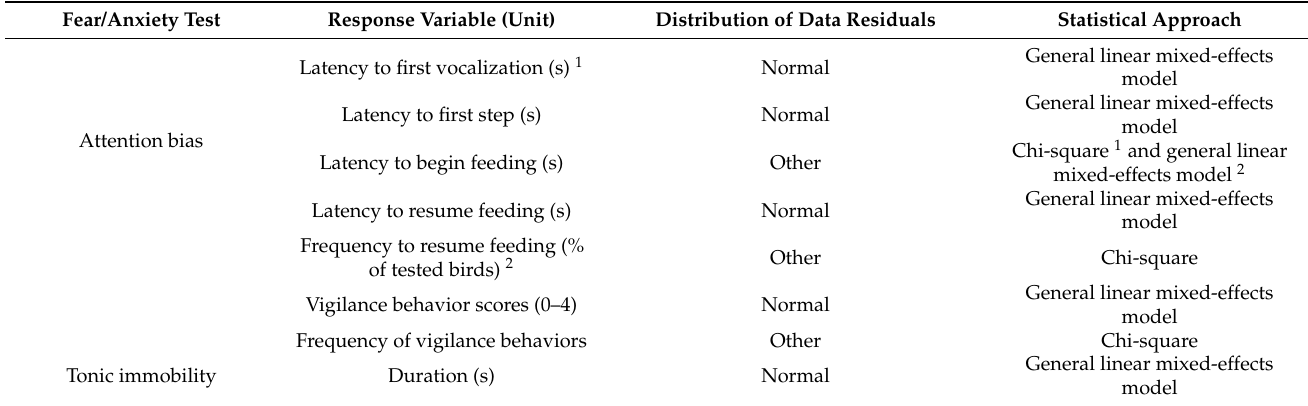
Table 3. Summary of data analyses for Experiments 1 and 2.